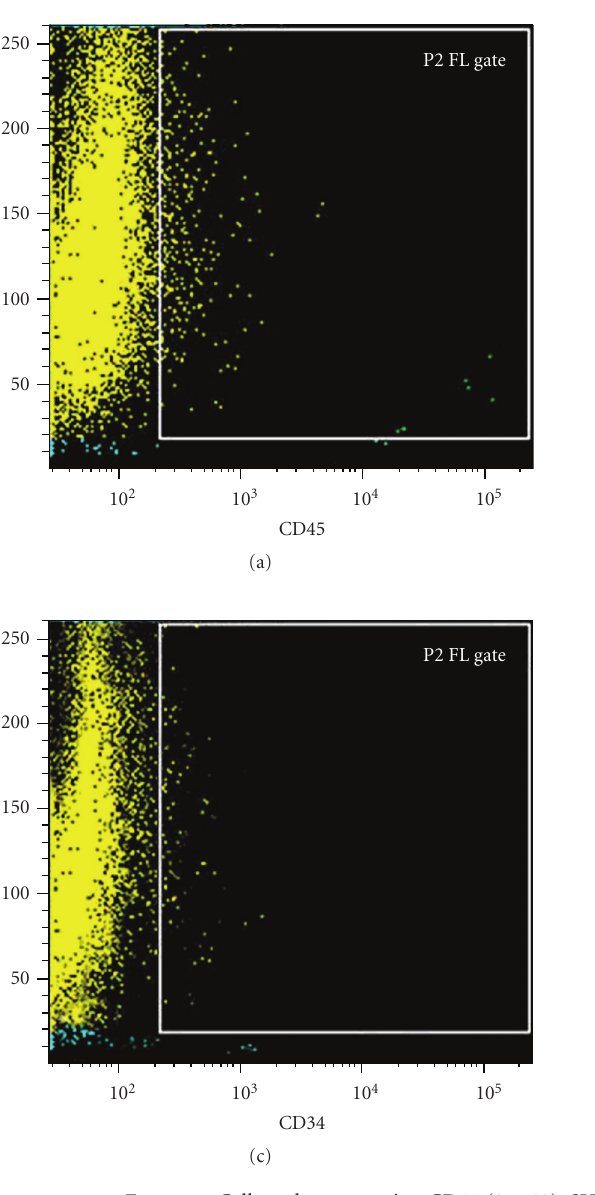
Figure 5: Cell marker expression CD44 (97.7%), SH3 (97.3%), CD34 (3.84%), and CD45